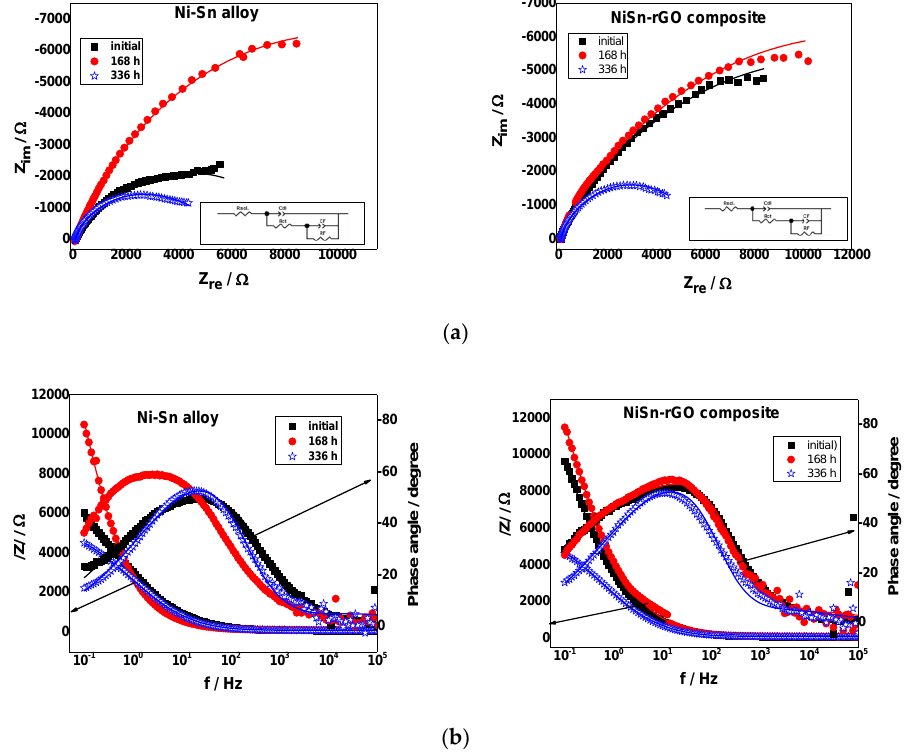
Figure 16. ( a ) Nyquist plots and ( b ) Bode plots for Ni–Sn alloy and NiSn-rGO composite coatings in 0.5 M NaCl at open circuit potential, after different periods of immersion (solid lines are the fit of the experimental data using the inserted equivalent circuit).